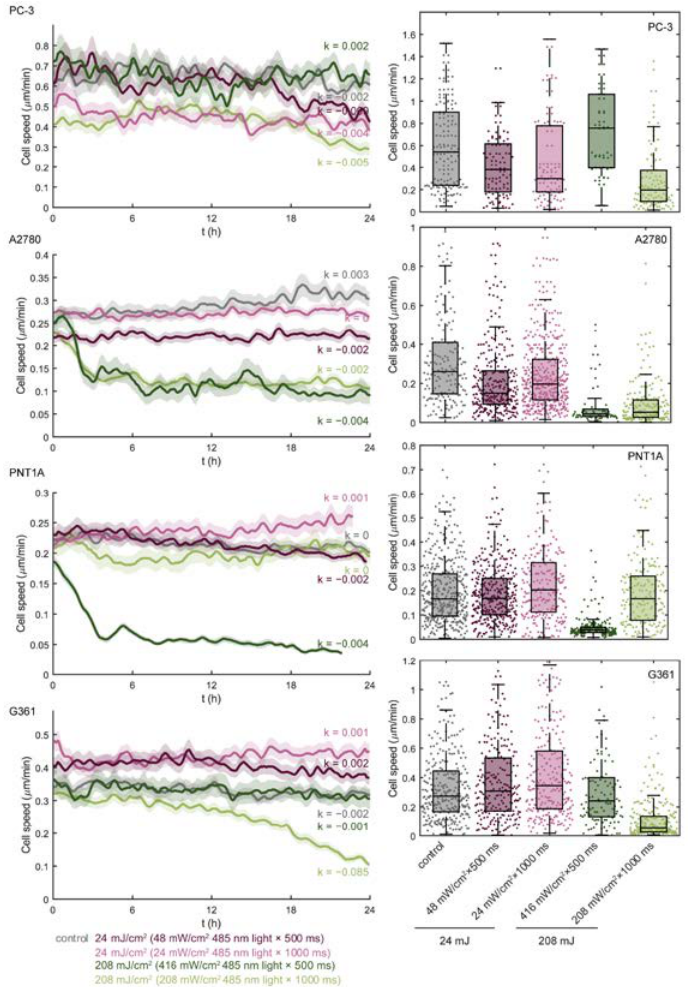
Figure 3. Real-time QPI-measured motility of cells affected by different doses of blue light. Real-time motility of PC-3, A2780, PNT1A, and G361 cells during 24 h of the experiment (left side of the figure). Lines are shown as the mean and standard error. K value means the slope of the least-square fitted line (increment of the value per hour). The end-point motility values of PC-3, A2780, PNT1A, and G361 cells after 24 h exposure to blue light (right side of the figure). Boxes are composed of the main box edges (25th and 75th percentile), central line (median) and whiskers (lowest and highest value of 1.5 of inter-quartile range).